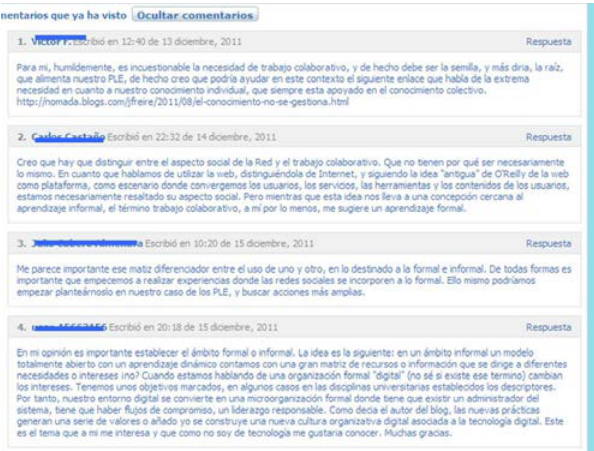
Figure 4 . Examples of contributions to the